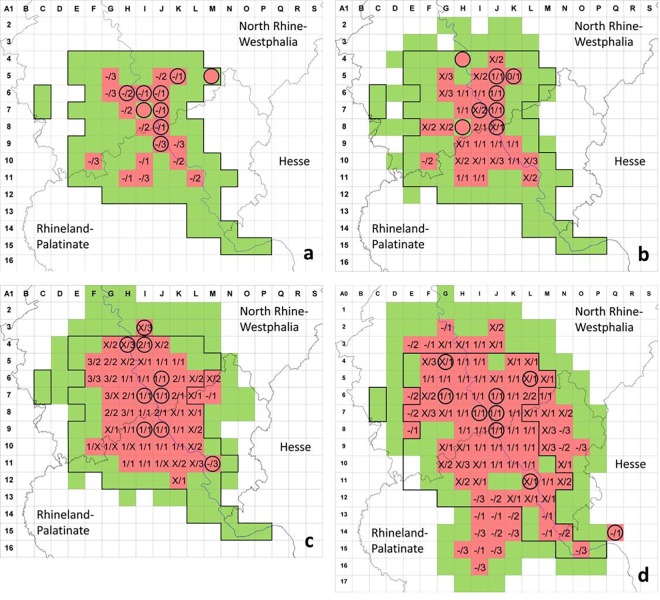
Area of West Germany in the federal states of North Rhine-Westphalia, Rhineland-Palatinate and Hesse checked for Ae. j. japonicus in 2012 (a), 2013 (b), 2014 (c) and 2015 (d). Red squares: grid cells positive, green squares: grid cells negative by cemetery inspection, circles: grid cells with Ae. j. japonicus submissions to the ‘Mueckenatlas’; figures in the grid cells denote findings in May/August of the respective year with ‘1’, ‘2’, ‘3’ representing the number of cemeteries inspected until Ae. j. japonicus was found, ‘X’ representing three negative cemeteries in case only one of the two collection seasons was positive, and ‘-‘ meaning not sampled. The area framed in bold marks the reference area used for statistical analysis.